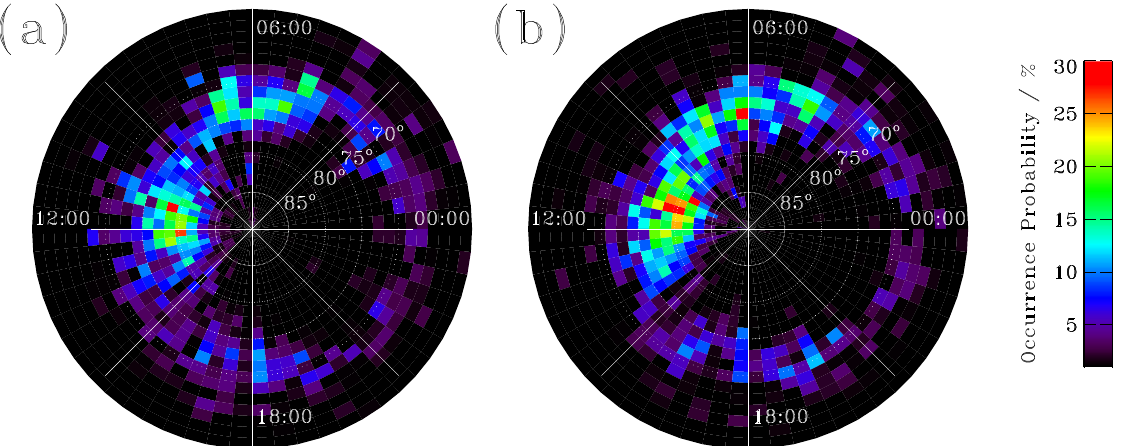
Fig. 3. He 2 + ion occurrence probabilities sampled during (a) IMF B Y > 0 and (b) IMF B Y < 0 conditions. The data are shown in the same format as Fig. 1.